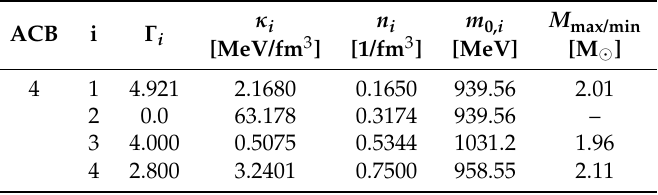
Table 1. Parameters for the four-polytrope EoS of Ref. [33], called “ACB4” in Ref. [26]. The corresponding description is presented in Equation (1) of the main text. The last column displays the maximum masses M max on the hadronic (hybrid) branch corresponding to region i = 1 ( i = 4). In addition, the minimal mass M min in region i = 3 of the hybrid branch is displayed in that